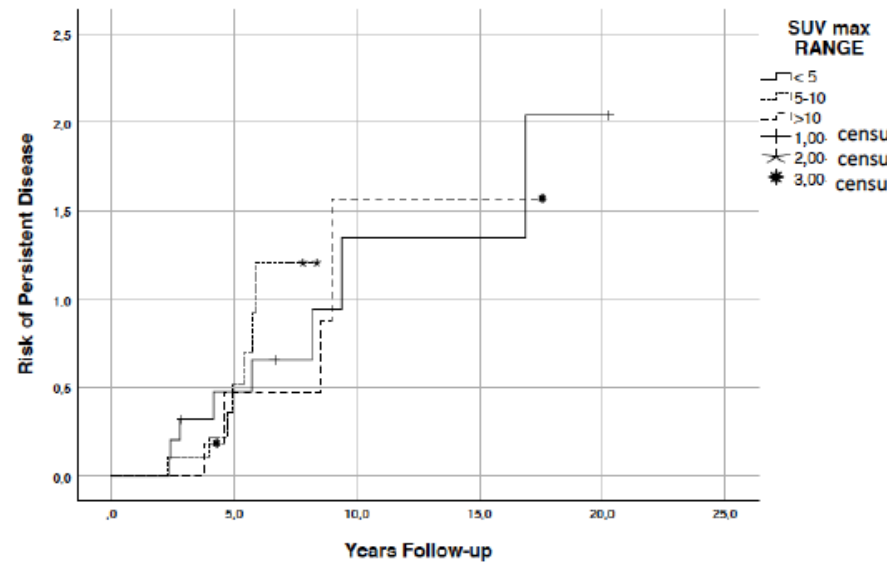
Figure 1. Kaplan-Meyer curves.